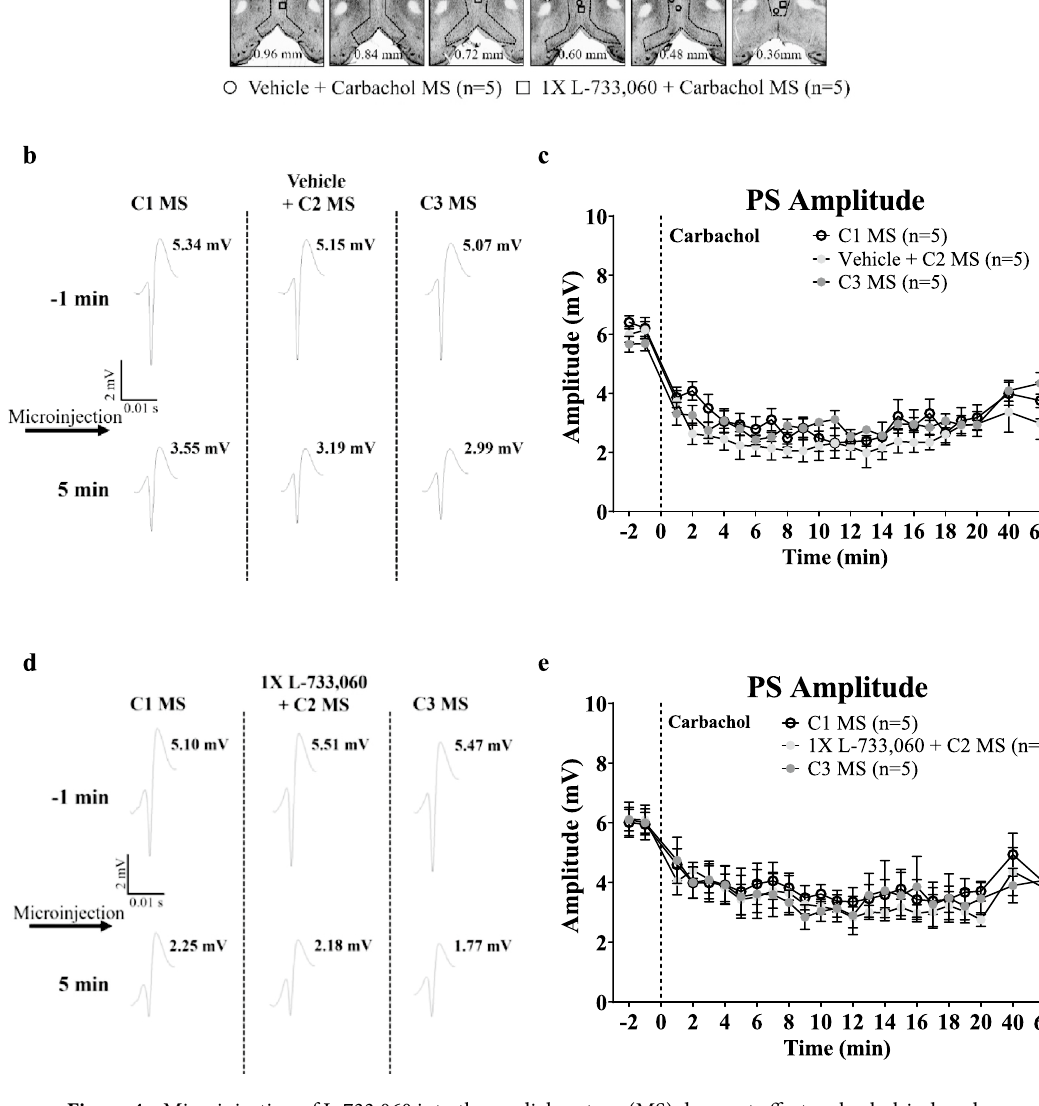
Figure 4. Microinjection of L-733,060 into the medial septum (MS) does not affect carbachol-induced suppression of CA1 PS in anaesthetized animals. ( a ) Composite of the microinjection sites in the MS was built as in Fig. 1. Carbachol (0.156 µg/µl, 0.5 µl) was microinjected three times (C1, C2 and C3), at least 1 h apart, with vehicle or L-733,060 (1 ×, 0.0176 µg/µl, 0.5 µl) microinjected 15 min before C2. ( b , d ) Representative PS traces following repeat carbachol microinjection into the MS. ( c , e ) Time course of change in amplitude of CA1 PS on repeat microinjection of carbachol. Note that carbachol elicited robust PS amplitude suppression which was unaffected by pre-treatment with vehicle or L-733,060. Data are presented are mean ± Effect of microinjection of L‑733,060 on the suppression of CA1 PS induced on hind paw injection of formalin (Fig. 5a–c). Hind paw injection of formalin in the anaesthetised animals is known to induce a suppression of CA1 PS 3 . The experiment in this study was performed to investigate if the formalin-induced suppression is sensitive to antagonism by intraseptal L-733,060. During the experiment, formalin was injected 15 min after pre-treatment with L-733,060 (1 × or 10 ×) or vehicle on microinjection into the MS (Fig. 5a–c). Consistent with the previous observations 3 , injection of formalin evoked a robust and sustained suppression of the ampli- tude of CA1 PS in vehicle pre-treated control experiments (Fig. 5b; Time, F 23, 184 = 6.40, p < 0.0001; one-way RM ANOVA followed by Newman Keuls post-hoc test, n = 9). A significant suppression was observed to 60th min after formalin injection. However, intraseptal L-733,060 (1 × or 10 ×) attenuated the suppression of CA1 PS induced on forma- lin injection (Fig. 5b,c). Statistical analyses indicated an overlapping effects of 1 × L-733,060 (n = 8) and 10 ×